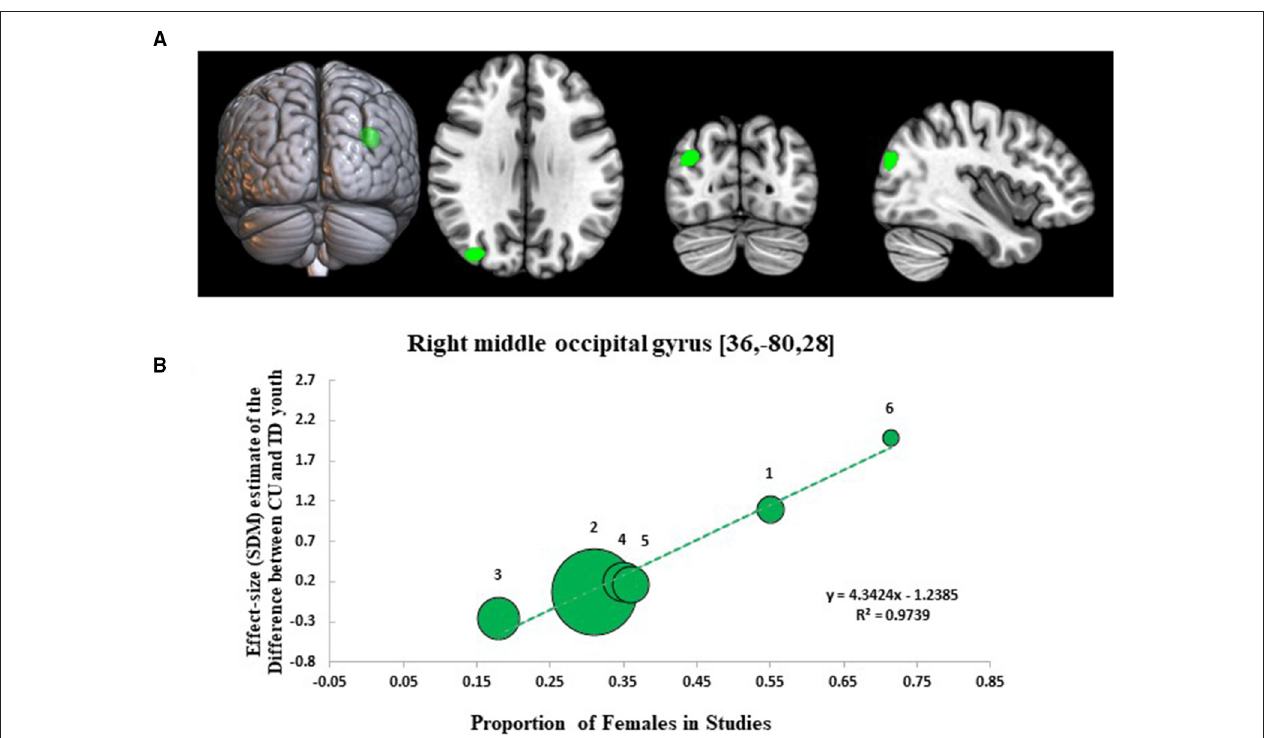
FIGURE 3 | Meta-regression results showing associations between proportion of females in studies with gray matter differences between cannabis using and typically developing youth. Sex-related meta-regression results. (A) Meta-regression results (CU > TD youth) showing associations between proportion of females in studies and gray matter differences between CU and TD youth shown in green. All results thresholded at p < 0.005. (B) Associations between sex and gray matter differences in the right middle occipital gyrus (162 voxels, SDM-Z = 3.953) (shown in green). Effect sizes (SDM-estimates) used to create the meta-regression plots were extracted from the peak of maximum slope significance. The meta-regression SDM-estimate value is derived from the proportion of studies that reported gray matter changes near the voxel so it is expected that some values are at 0 or near + /– 1. Each included study is represented as a numbered dot, with the dot size reflecting relative total sample size of each specific study in comparison to the average total sample size of all six studies included in the regression. Study key: 1 = Gilman et al. ( 39); 2 = Thayer et al. (41); 3 = Weiland et al. (11); 4 = Orr et al. (12); 5 = Cousijn et al. (40); 6 = Jarvis et al.